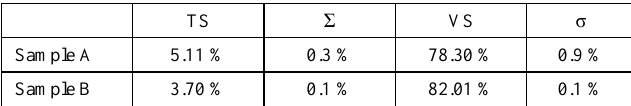
TS AND VS VALUES OF C. DEMERSUM WITH STANDART